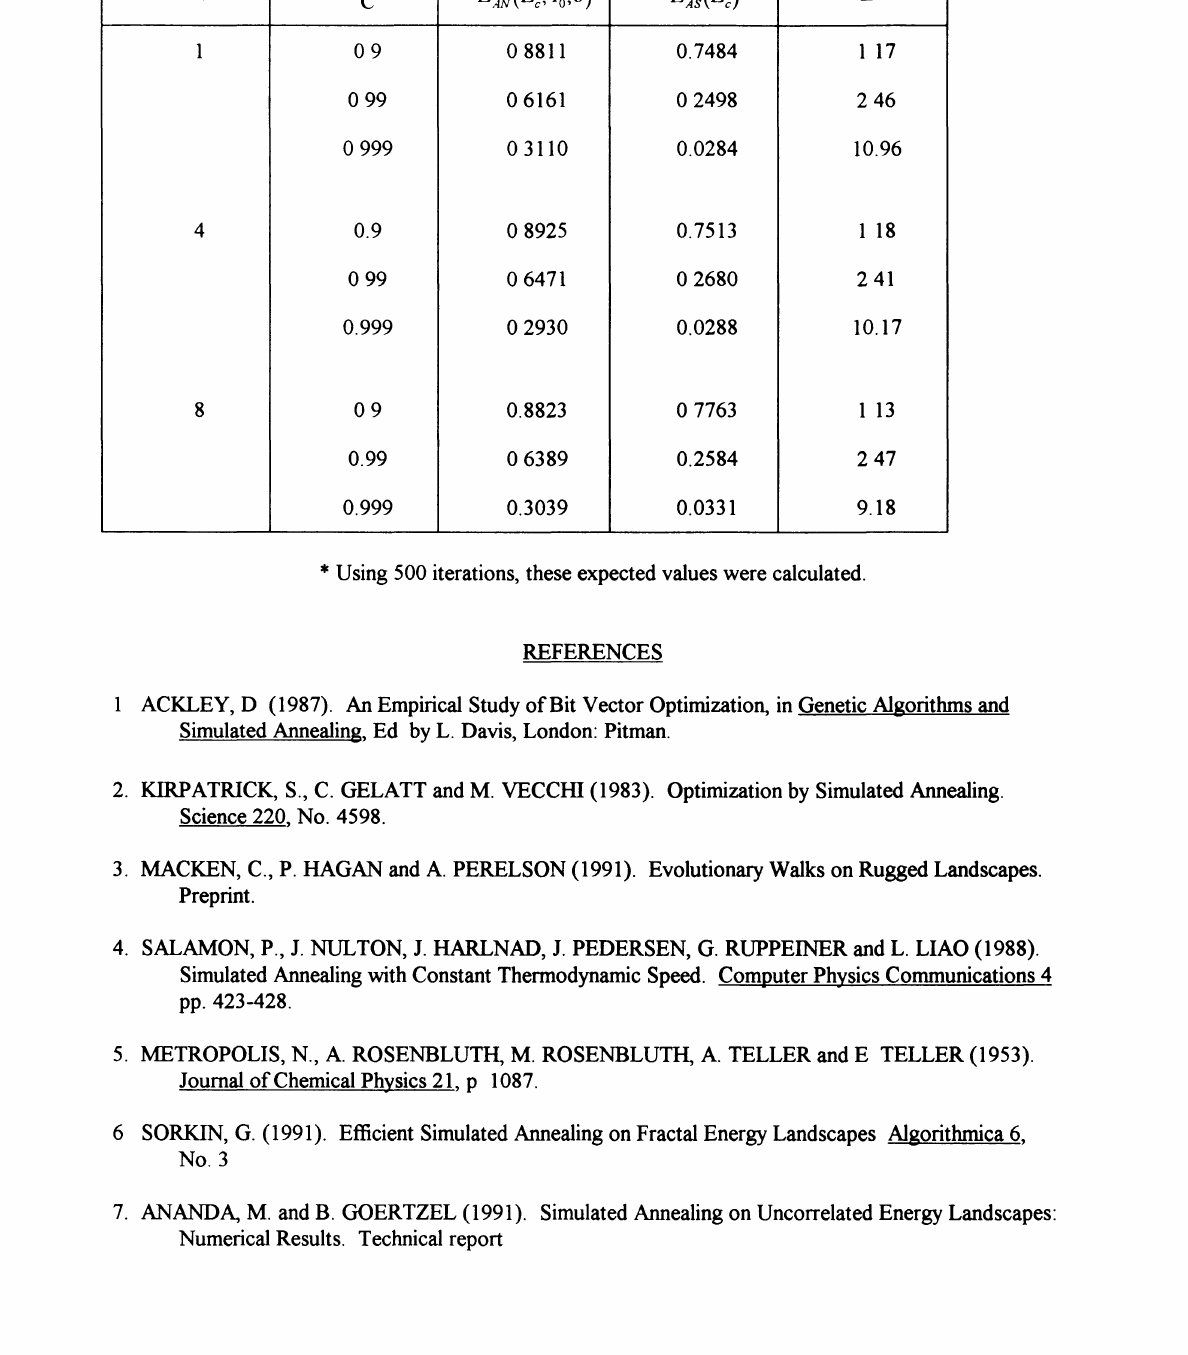
Table 3 Average fitness for the power